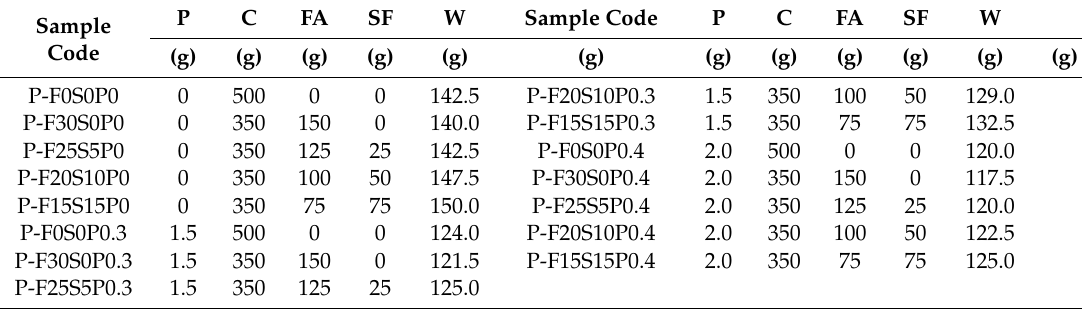
Table 3. The mix proportions of the paste